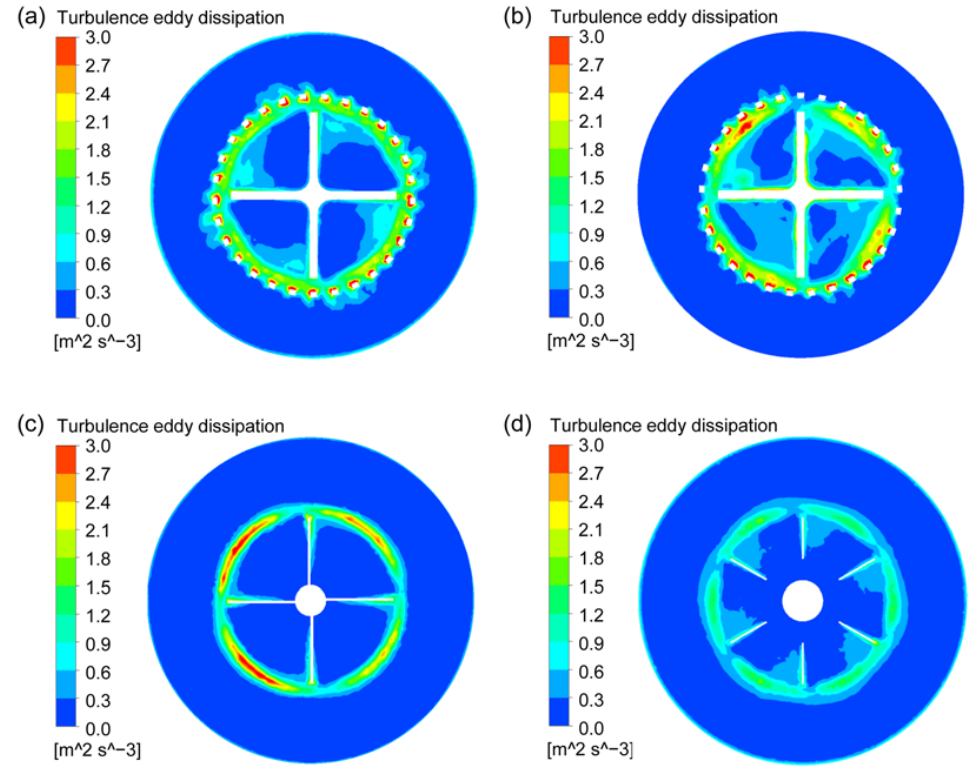
Figure 9. The distribution of turbulence energy dissipation rate on the horizontal plane ( Z = 0.038 m) at the stirring speed of 400 rpm for the four types of agitators; ( a ) CSRS agitator; ( b ) HCSRS agitator; ( c ) A200 agitator; ( d ) Rushton agitator.